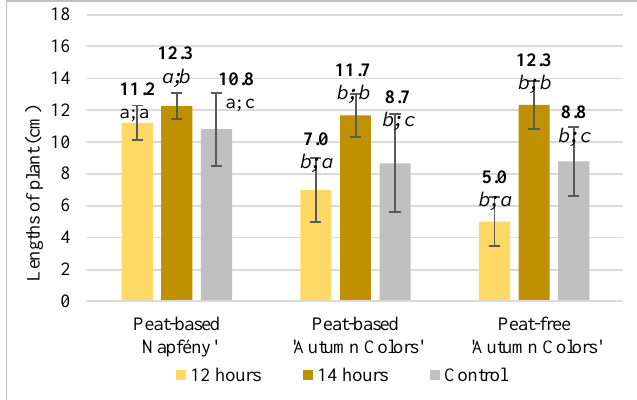
Table 1. Lengths of 11 and 16 weeks Rudbeckia hirta L. plantlets depending on photoperiodic lighting treatments and media (University of Debrecen, Biological Research and Plant Experiment Greenhouse - Biodrome, Debrecen, Hungary, 2021).